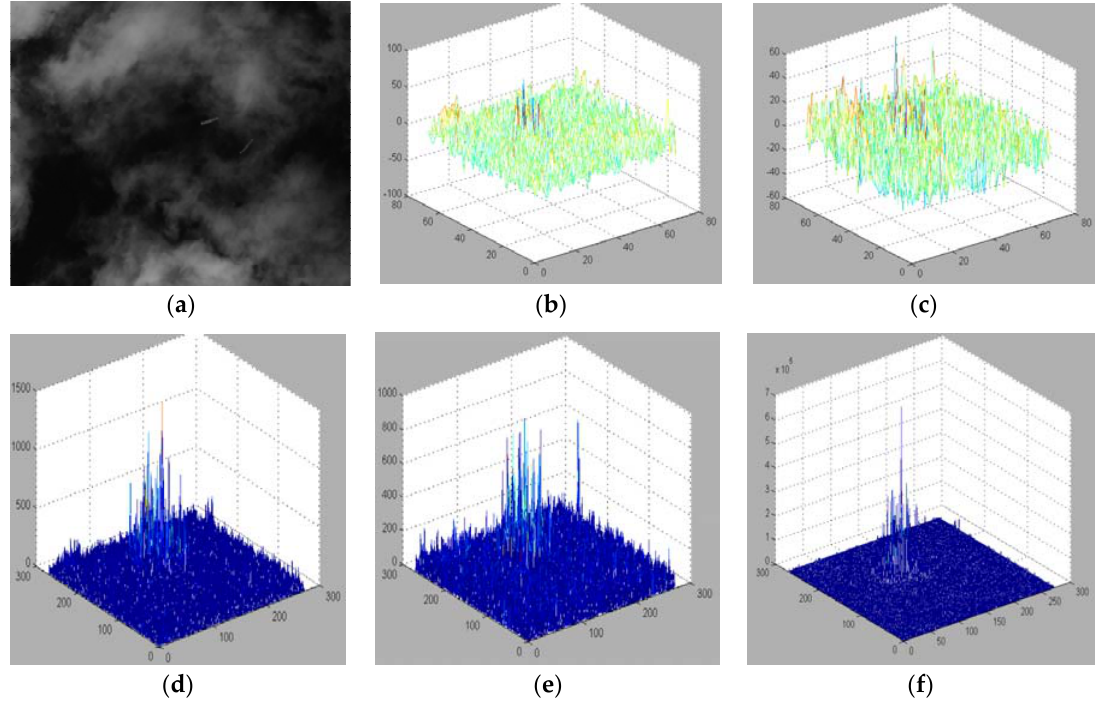
Figure 6. Comparison between DWT and EWT. ( a ) The original image; ( b ) horizontal high frequency component of DWT; ( c ) vertical high frequency component of DWT; ( d ) horizontal high frequency component of EWT; ( e ) vertical high frequency component of EWT; ( f ) multiplication of the high-frequency coefficients.